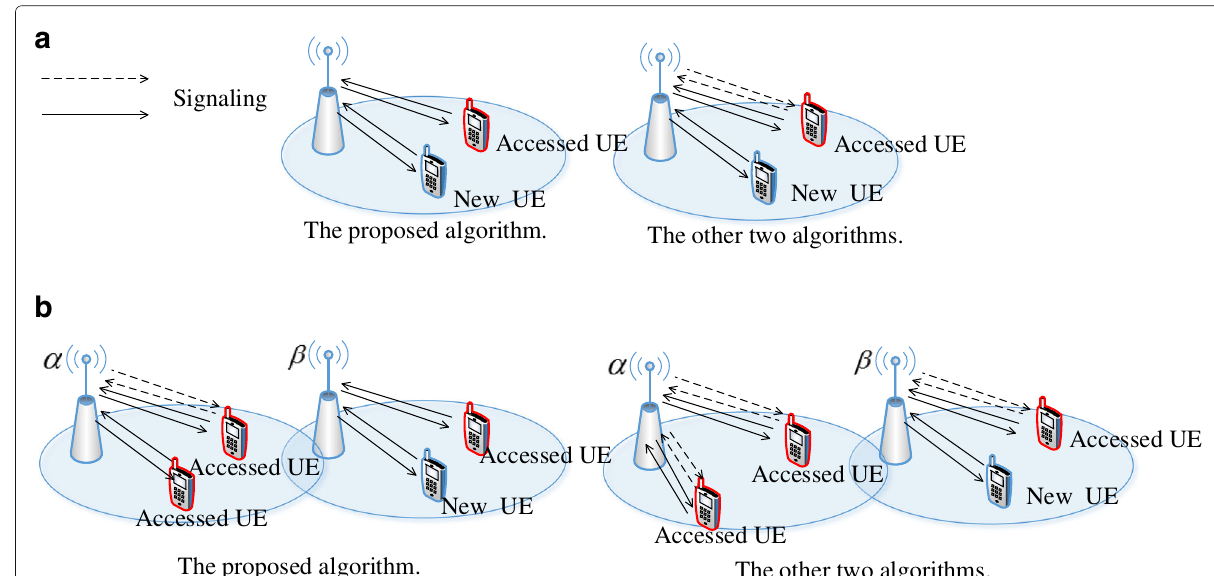
Fig. 9 Comparison of signaling in access process. a The PRB of small cell is sufficient. b The PRB of small cell is